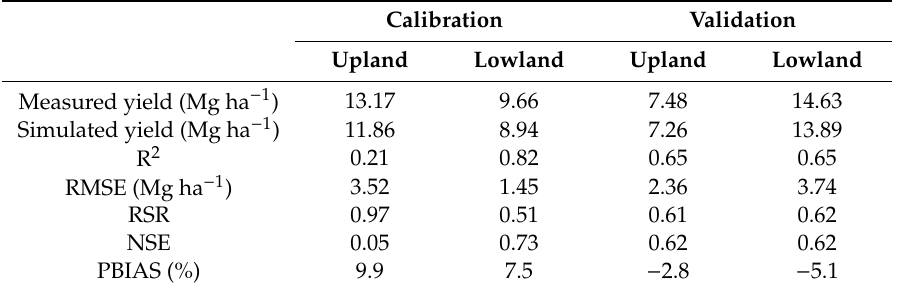
Table3. MeasuredandsimulatedyieldsandALMANACmodelcalibrationandvalidationperformances based on R2, RMSE, RSR, NSE, and PBIAS. R 2 is Pearson’s correlation coe ffi cient of determination; RMSE is root mean square error; RSR is RMSE-observations standard deviation ratio; NSE is Nash–Sutcli ff e e ffi ciency; and PBIAS is percent